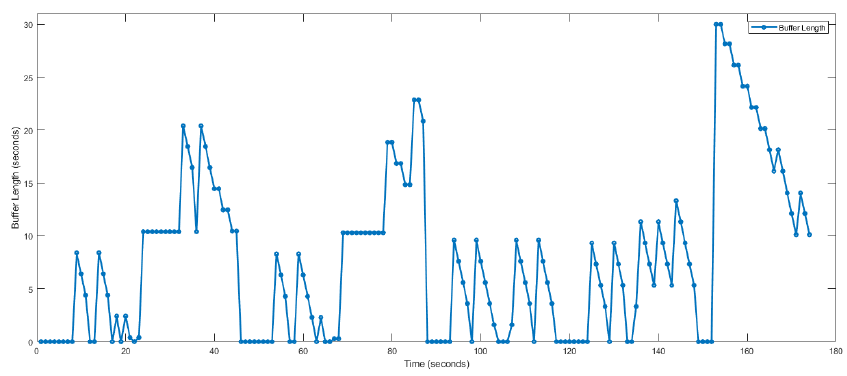
Figure 5. Results of buffer length network feature experimentation trials.